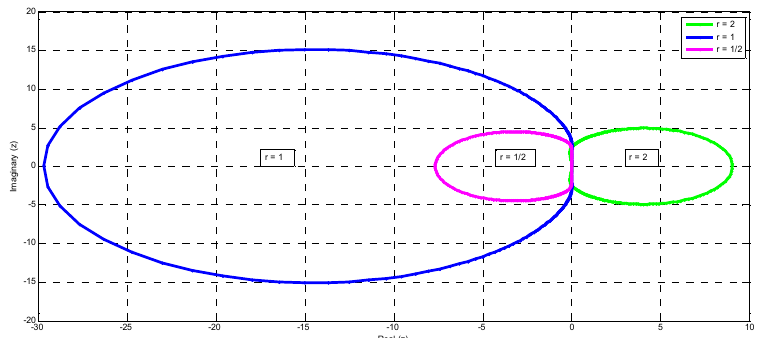
Figure 2. Stability regions of the VSHBM.